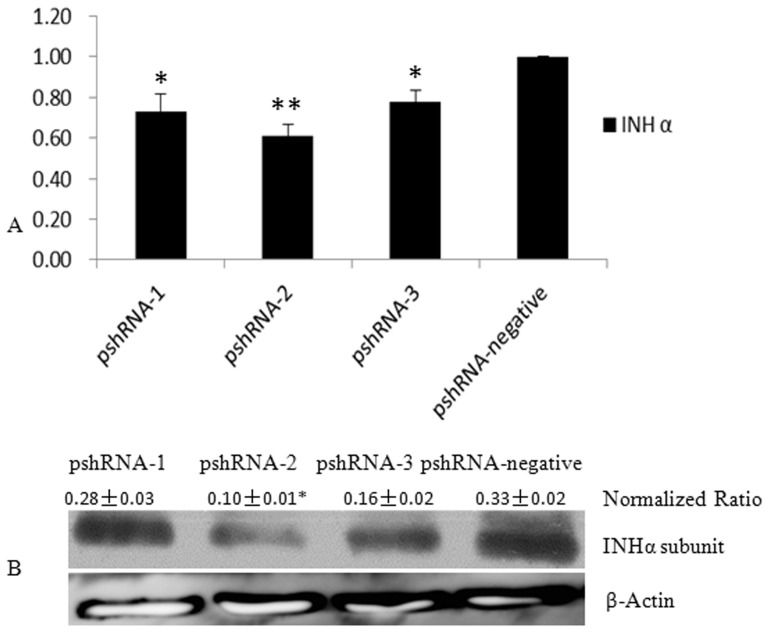
Detection of INH α subunit in the anterior pituitary cells after 48 h transfected with pshRNA-1, pshRNA-2, pshRNA-3 and pshRNA-negative, respectively. A:Transcription levels of INH α gene in the anterior pituitary cells transfected with pshRNA-1, pshRNA-2, pshRNA-3 and pshRNA-negative respectively. The statistical differences were tested using one-way ANOVA. Asterisk [*] means P<0.05, two asterisks means P<0.01. B: INHα subunit expression were detected by western blotting in the anterior pituitary cells after 48 h transfected with pshRNA-1, pshRNA-2, pshRNA-3 and pshRNA-negative respectively.